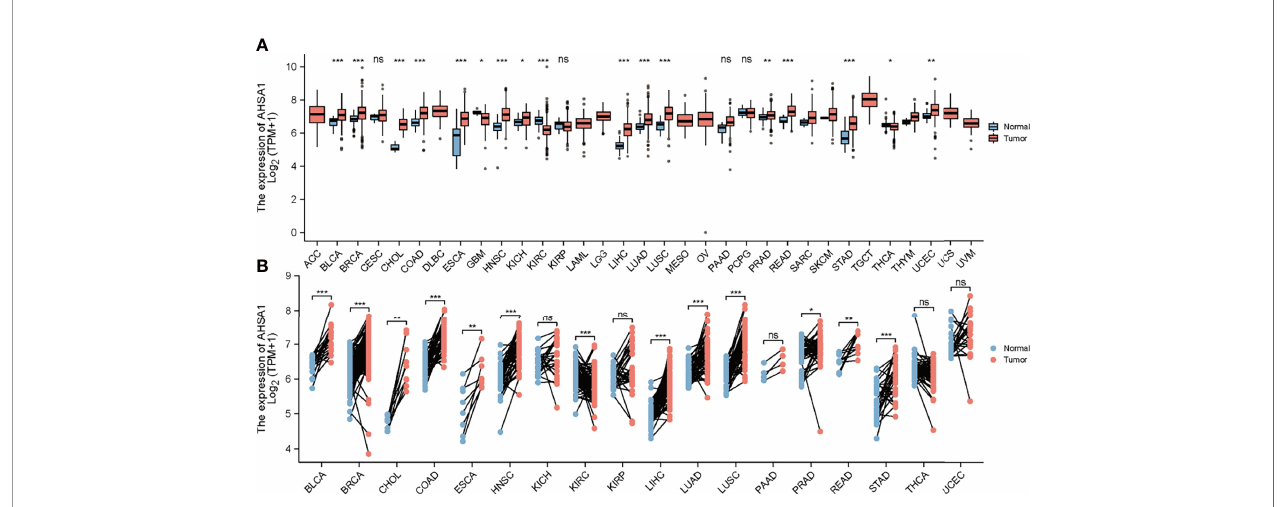
FIGURE 1 | Differential expression analysis of AHSA1 . (A) Expression of AHSA1 mRNA in pan-cancer. (B) The expression differences of AHSA1 in tumor and corresponding adjacent tissues were compared with paired analysis. Mann-Whitney U test was used for this analysis, ns, p ≥ 0.05; *p< 0.05; **p<0.01;